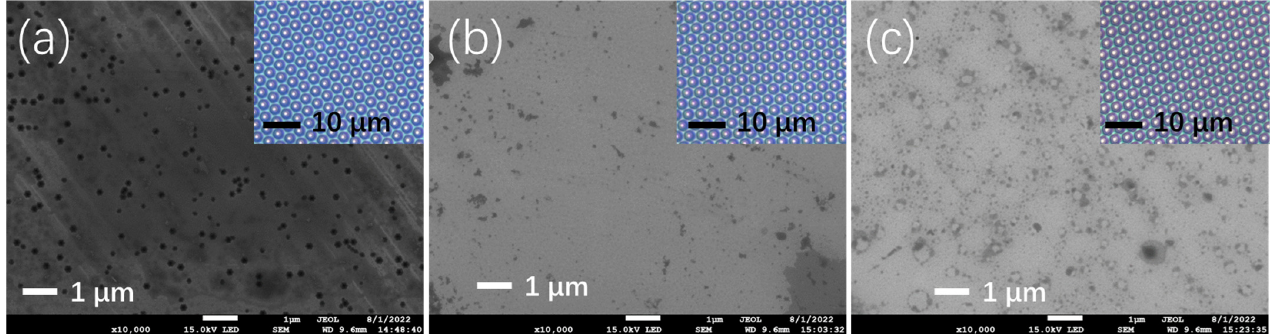
Figure 2. Scanning electron microscopy of the ( a ) Si-doped GaN, ( b ) undoped GaN, and ( c ) Mg-doped GaN thin film (the inset photographs were taken using a transmission optical microscope).